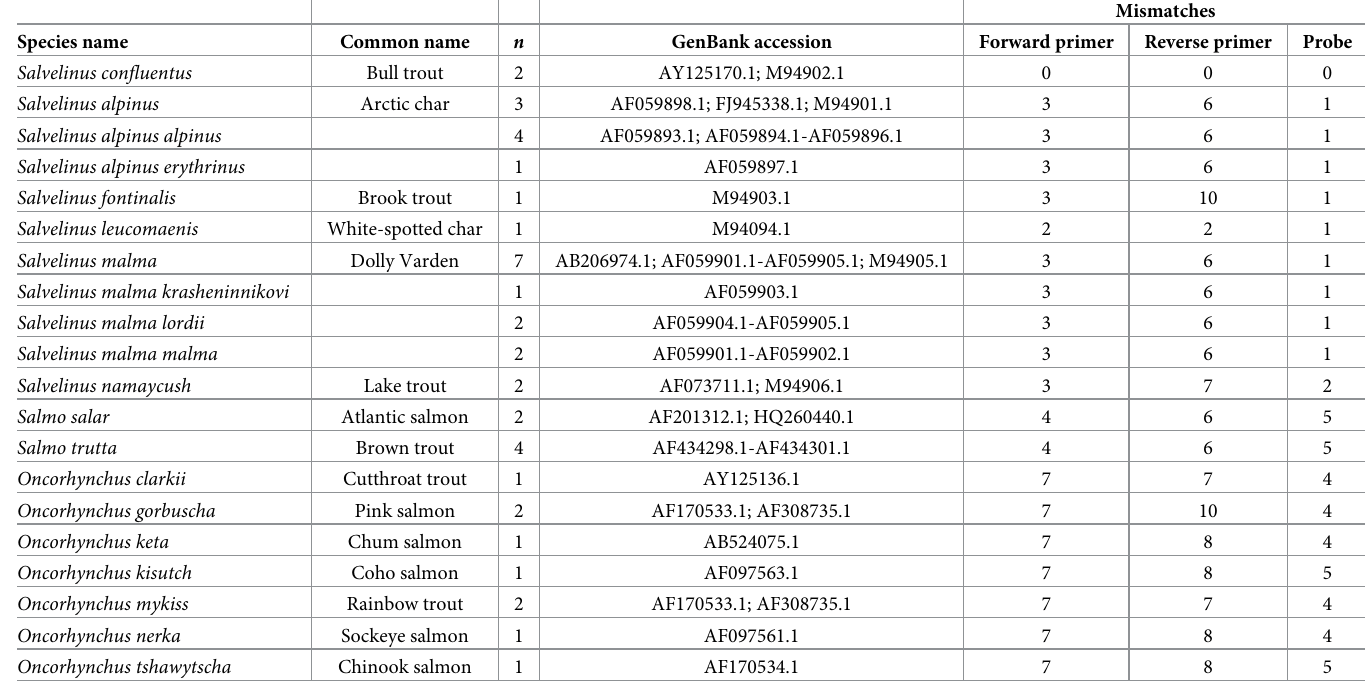
Table 1. Species, sample size ( n ), and GenBank accession number for DNA sequences used for in silico development of the bull trout ITSI eDNA assay. Also included is the minimum number of mismatches with the assay and the sequence